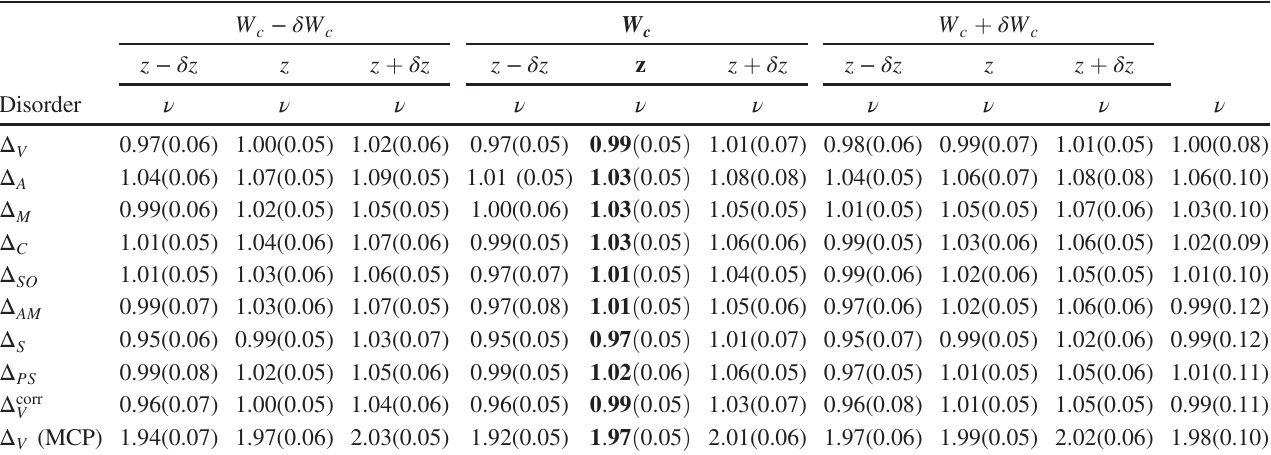
TABLE IV. Details of the data analysis for the computation of the correlation length exponent ν across the WSM-metal QPT driven by ), axial potential ( Δ ), magnetic ( Δ ), current ( Δ ), spin-orbit ( Δ ), axial magnetic ( Δ ), scalar mass ( Δ ), and potential ( Δ V A M C SO AM S pseudoscalar mass ( Δ ) disorder (see Table III for definition), where the disorder is assumed to be uniformly and independently PS distributed within ½ − W; W (cid:3) (first eight rows). We here show the variation of ν with (a) the variation of the location of the WSM-metal δ W QCP (denoted by W ) and (b) from the fitting error of z (denoted by z (cid:2) δ z ). See Tables I and II for W , z , and δ z , and throughout c (cid:2) c c 0 . 05 . The second to the last row represents the same analysis but in the presence of correlated potential disorder ( Δ corr we have δ W ), c ¼ V discussed in Appendix F, while the last row shows similar analysis across the potential disorder-driven critical anisotropic semimetal- metal transition through the multicritical point (discussed in Sec. III). The quantities in parentheses represent corresponding fitting error for a given value of ν for the specific value of critical disorder strength and dynamic scaling exponent; see Appendix E for discussion. Each value of ν and the corresponding fitting error is determined by comparing ϱ ð 0 Þ with δ ð d − z Þ ν for given values of W and z , see, c